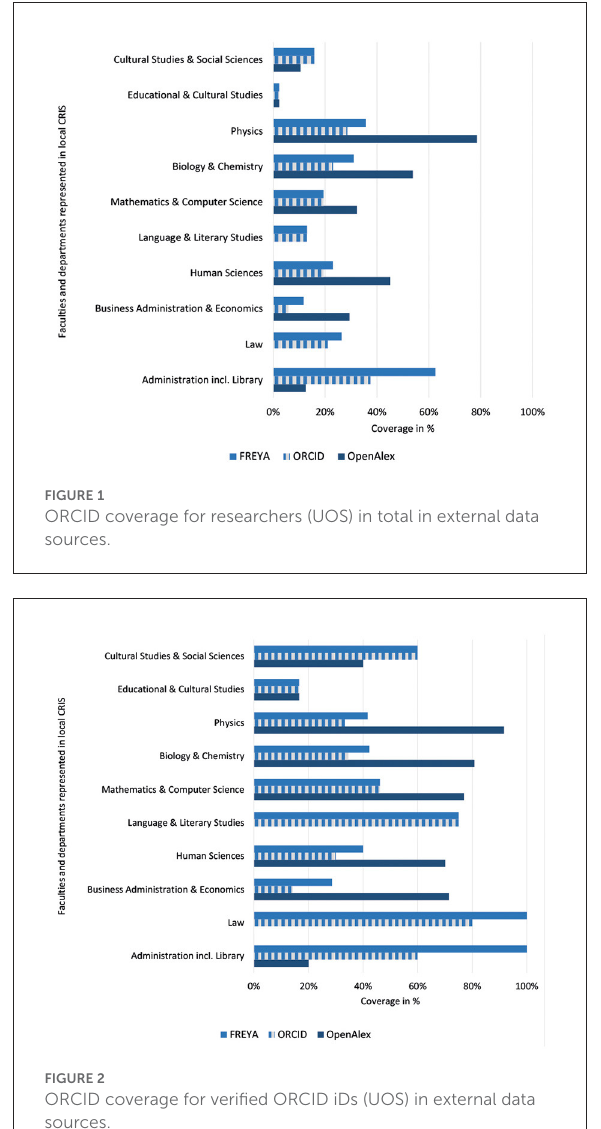
FIGURE2 ORCID coverage for verified ORCID iDs (UOS) in external data sources.